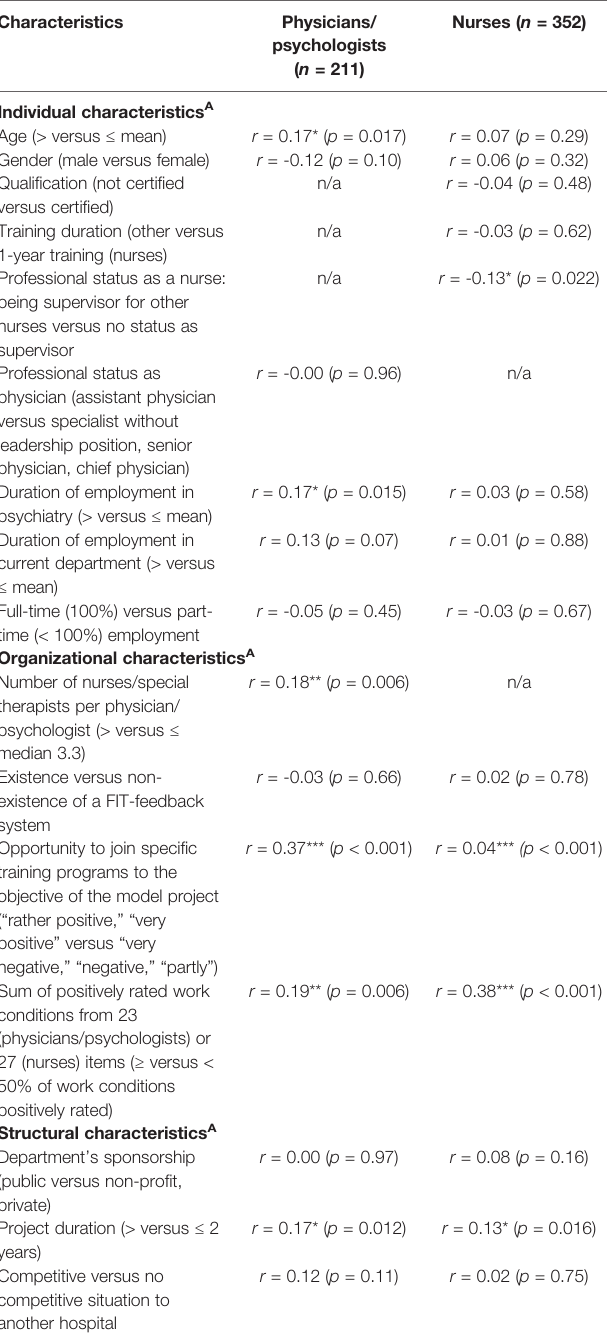
TABLE 4 | Full binary logistic regression for evaluations (EV) of physicians/ psychologists and selected independent variables ( N = 68). Variable